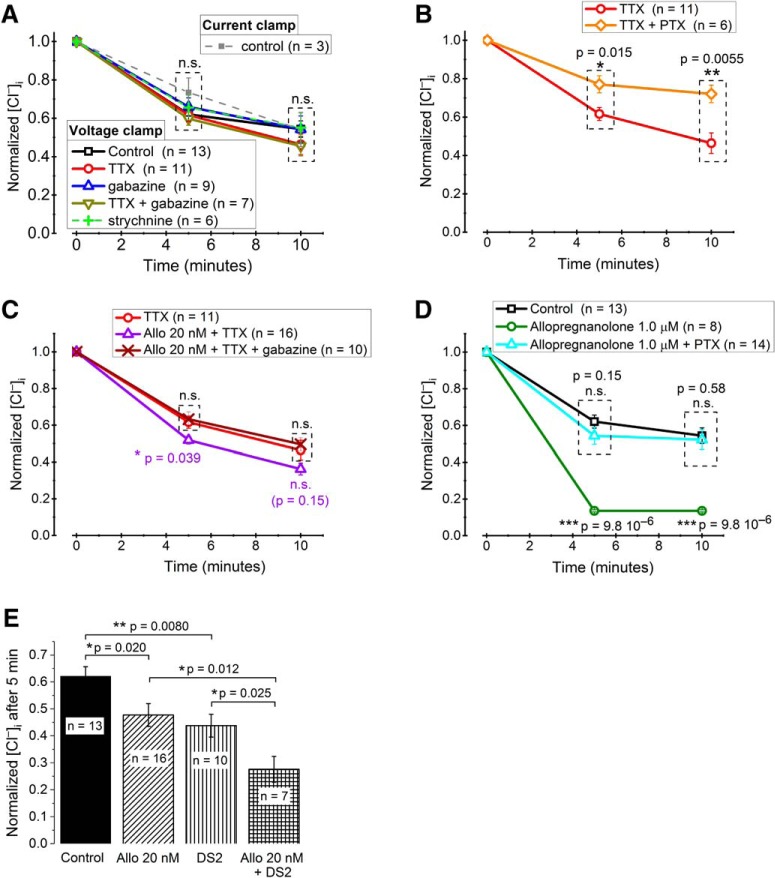
Role of spontaneously open GABAA receptors and of neurosteroid-potentiated mIPSCs for [Cl–]i recovery. A, Relative [Cl–]i, illustrating recovery 5 and 10 min after Cl– loading. Current-clamp (0 pA) between test ramps during recovery phase: control only. Voltage-clamp (–74 mV) between test ramps during recovery phase: control, 2.0 µM TTX, 3.0 µM gabazine, a combination of TTX and gabazine, or 10 µM strychnine, as indicated. Note the lack of significant differences. B, Relative [Cl–]i (as in A, voltage-clamp only), with significantly reduced recovery in the presence of 100 µM PTX. C, Relative [Cl–]i (as in B), showing gabazine-sensitive enhancement of recovery in the presence of 2.0 µM TTX and the neurosteroid allopregnanolone (Allo) in a concentration (20 nM) known to enhance mIPSC frequency and prolong mIPSC decay. D, Relative [Cl–]i (as in B) showing the dramatic enhancement of [Cl–]i recovery by allopregnanolone in a concentration (1.0 µM) that may directly activate GABAA receptors and the block of this effect by 100 µM PTX. E, Comparison of the effects of 20 nM Allo, DS2 and a combination of Allo and DS2 on normalized [Cl–]i after 5 min of recovery from a Cl– load as in A–D. Note the highly significant effect of DS2 and the additive effects of Allo and DS2. To compare data recorded at slightly different times in A–E, interpolation was used for data pairs closest to the time points illustrated and [Cl–]i was normalized to the maximal concentration during loading.